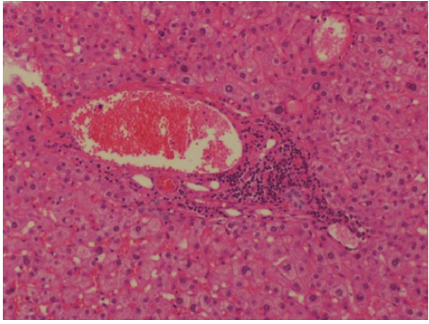
Figure 3: High power histological image of ectopic liver